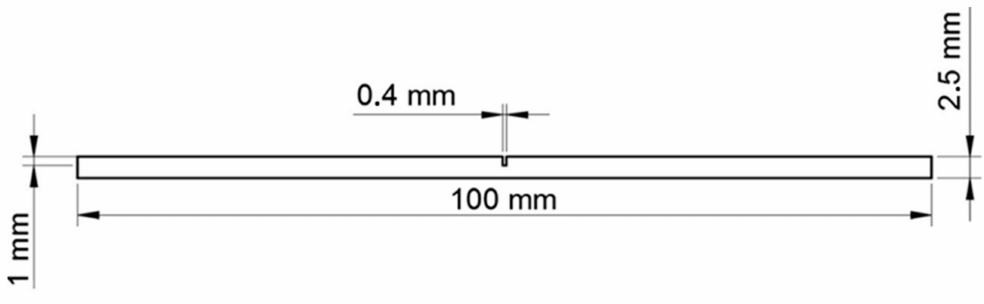
Figure 2. Geometry of the notched